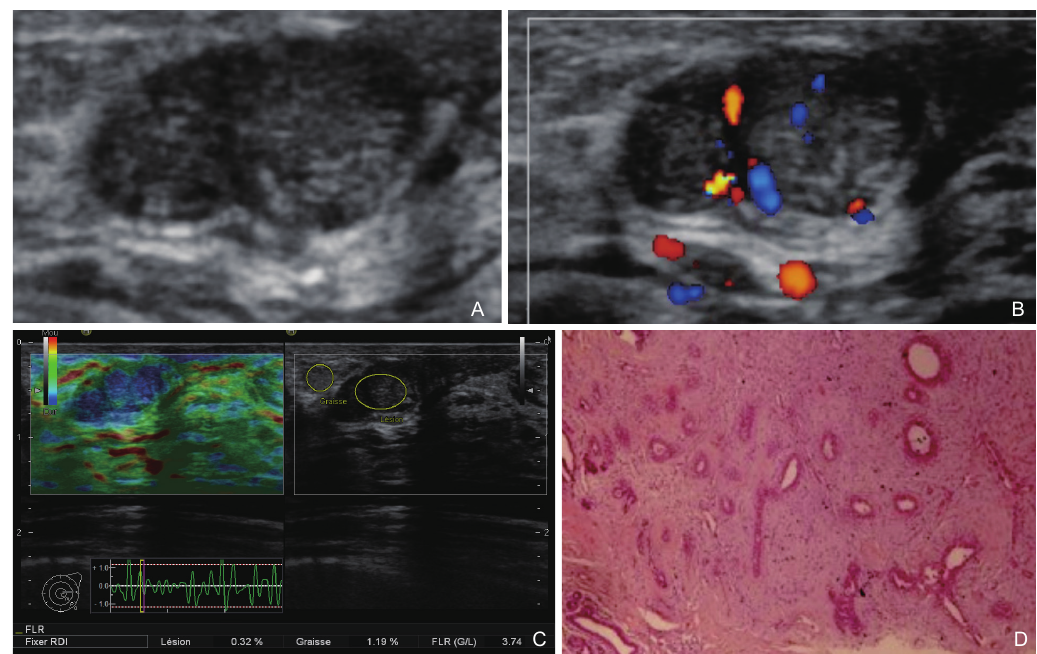
Figure 4 A 46-year-old woman with a phyllodes tumor. (A) The B-mode US image shows a breast mass classified as BI-RADS category 3; (B) The color Doppler US image shows high vascularity (vessels in rim and internal vascularity); (C) The strain elastography image shows a strain ratio was 3.74; (D) Pathologic section of the lesion shows phyllodes tumor with Markedly cellular